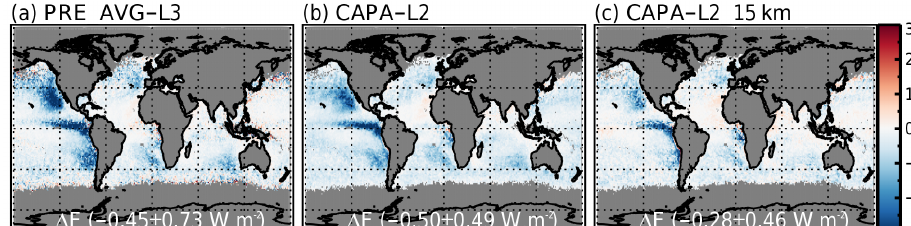
Figure 4. Intrinsic aerosol indirect radiative forcing computed using AATSR observations over oceanic 1 ◦ × 1 ◦ regions during the period 2002–2012. Oceanic mean and standard deviation values are from the spatial distribution of the forcing ( (cid:49)F